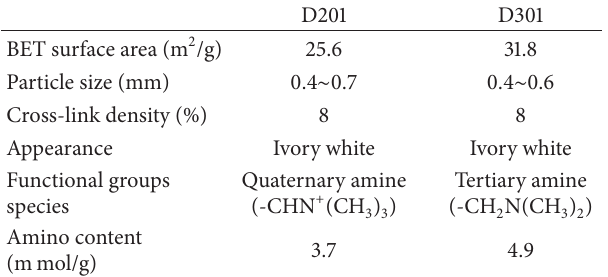
Table 1: Salient properties of polymeric